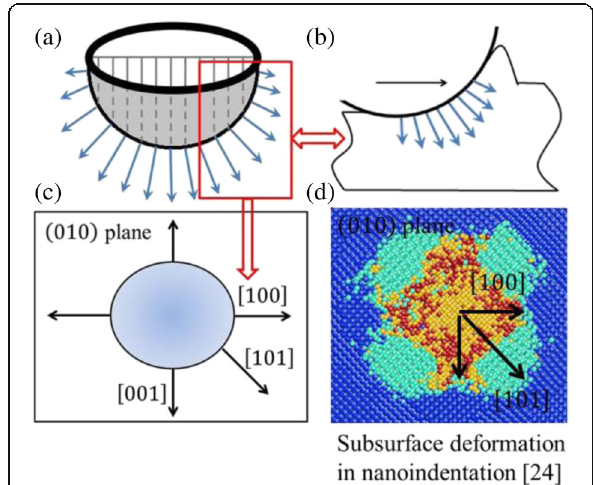
Fig. 13 a The stress directions on the normal cross section in nanoindentation with a spherical indenter. b The stress directions on the normal cross section in nanometric cutting with a tool nose radius. c Schematic illustration of orientations on the (010) crystal plane of monocrystalline germanium. d The subsurface deformation induced by nanoindentation on the (010) plane of